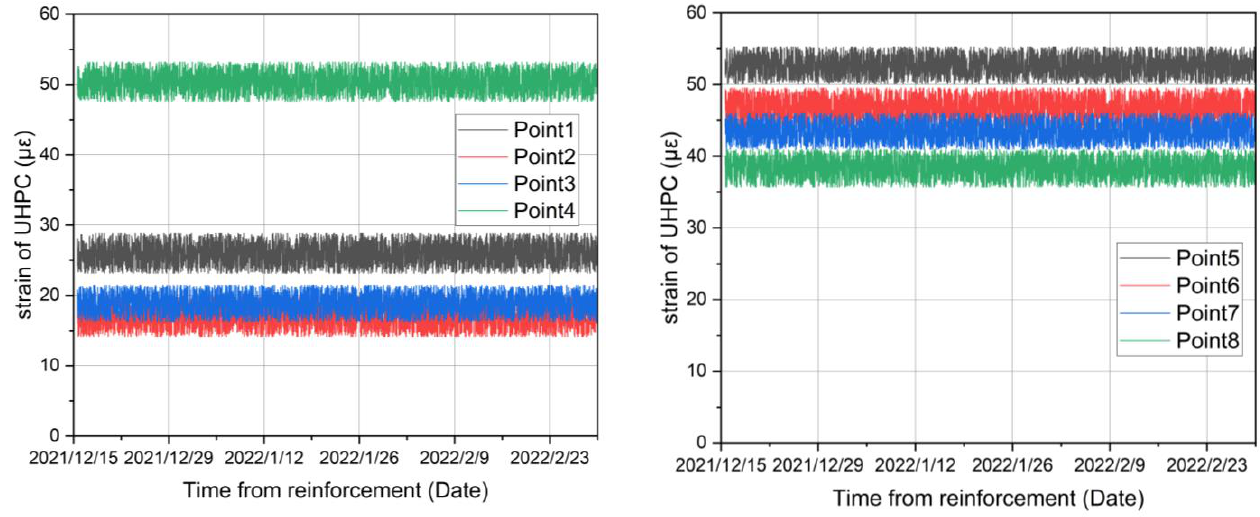
Figure 12. UHPC strain. Figure 12. UHPC